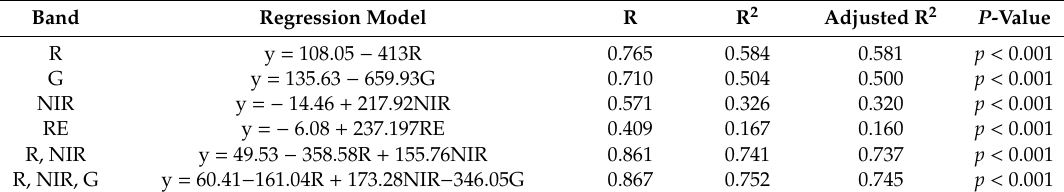
Table 2. Estimating VGC density from spectral bands ( n = 115).